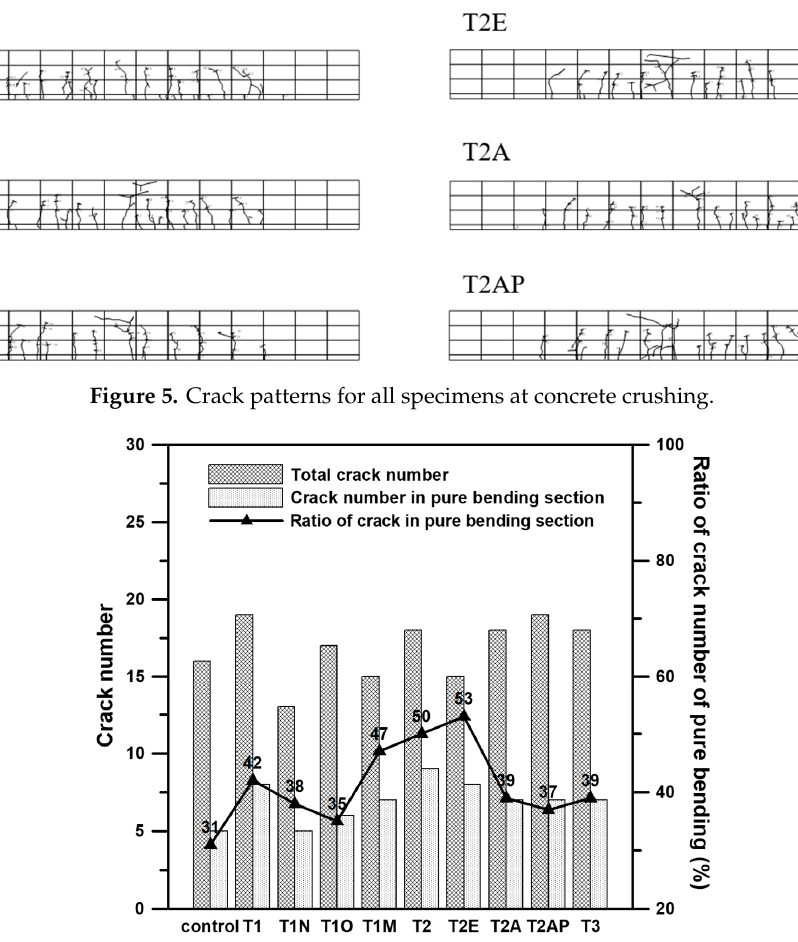
Figure 6. Crack number of all specimens.